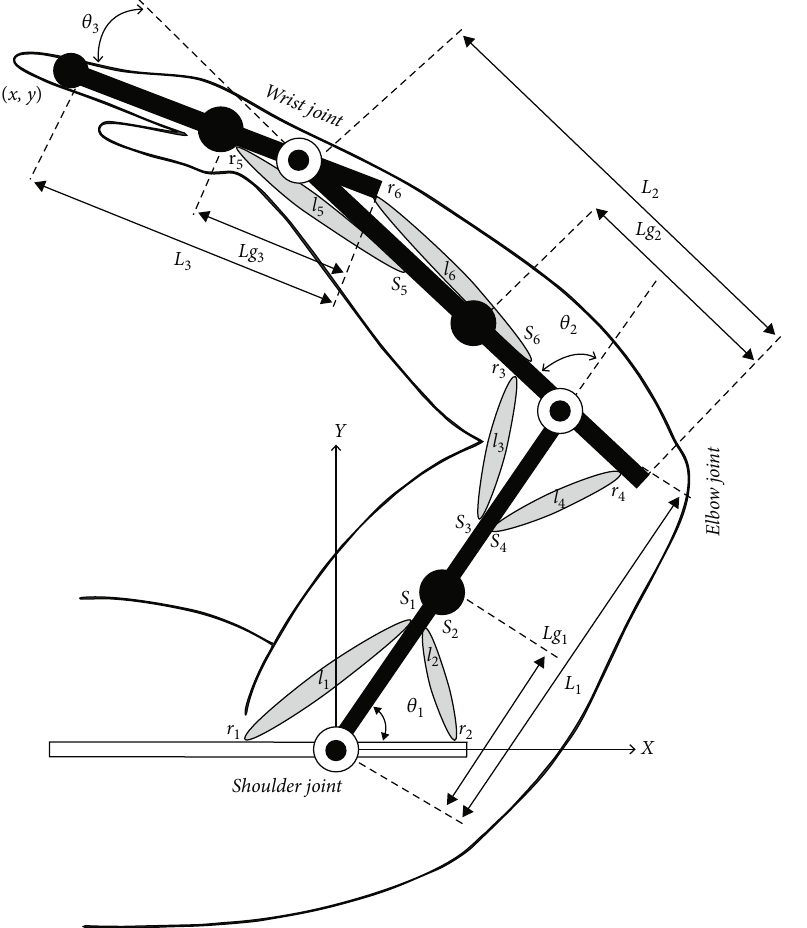
Figure 1: Schematic view of the 3-DOF musculoskeletal